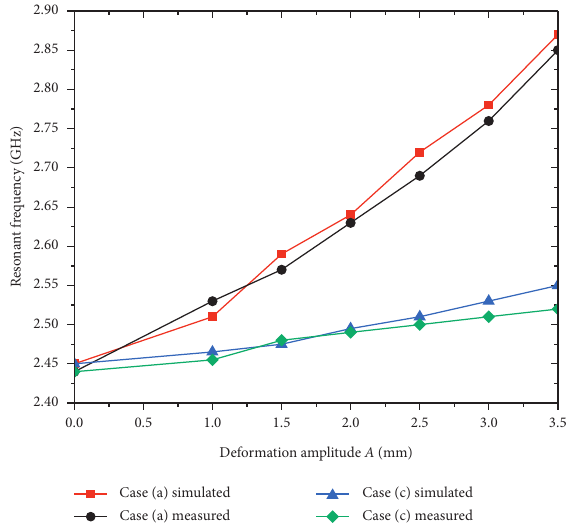
Figure 14: The simulation results are compared with the measured